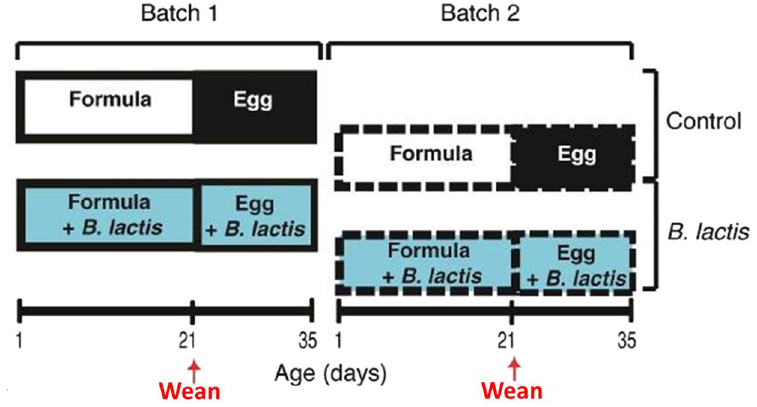
Figure 7. Animal trial: Schematic representation of the experimental setup depicts batch 1 (n = 6), batch 2 (n = 6), treatment (supplemented with B. lactis NCC2818 from 1 day old, n = 6) and untreated groups (no B. lactis NCC2818, n = 6). Piglets were fed formula milk before being weaned at 21 days (denoted by red arrow) onto an egg protein-based diet until the experiment concluded at 35 days. A detailed schematic of the experimental design is available in the supplementary data (Supplementary Fig.